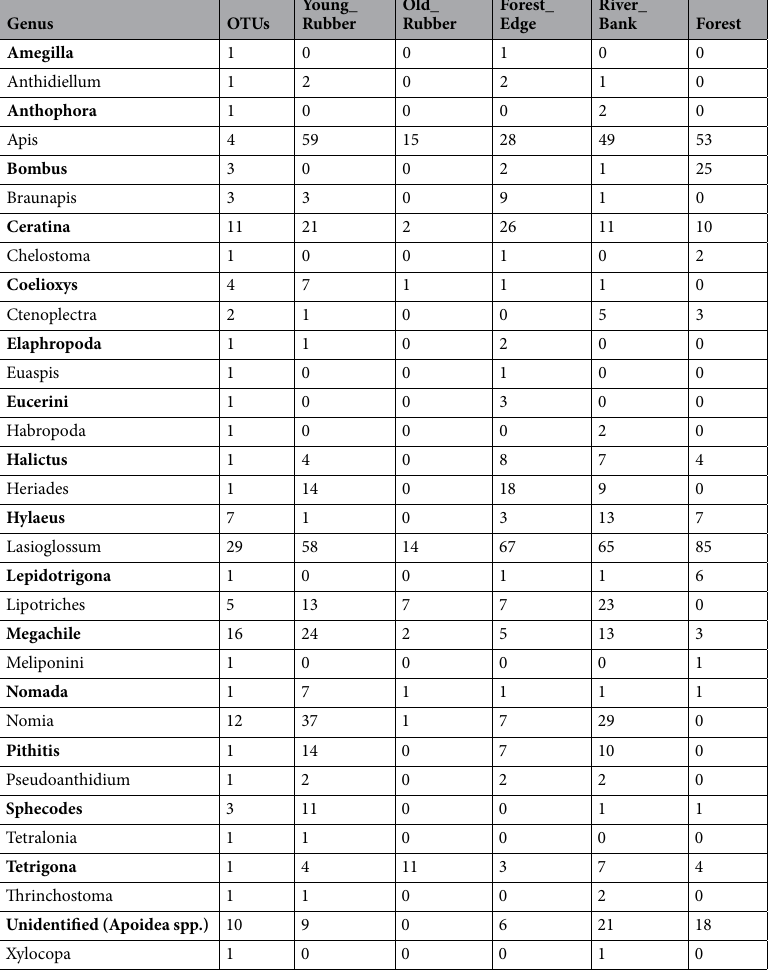
Table 2. Genus information. For information tabulated for OTUs or individuals, see Supplementary Dataset